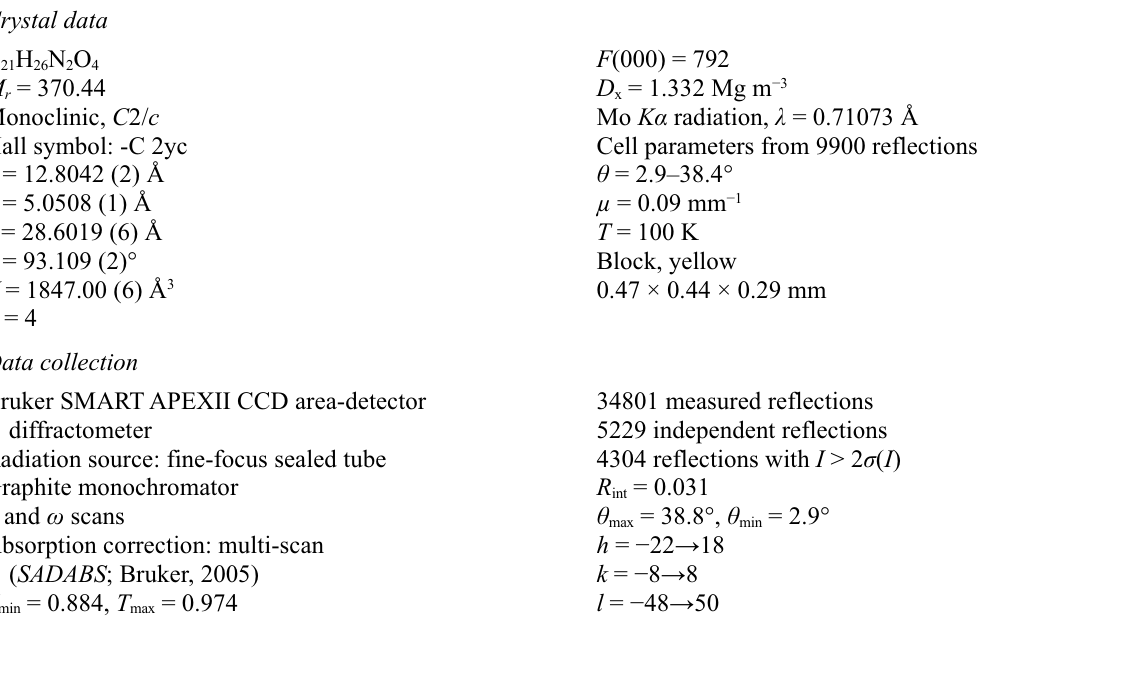
The crystal packing, showing zigzag arrangement of molecules along the c axis. 4,4 ′ -Dimethoxy-2,2 ′ -[1,1 ′